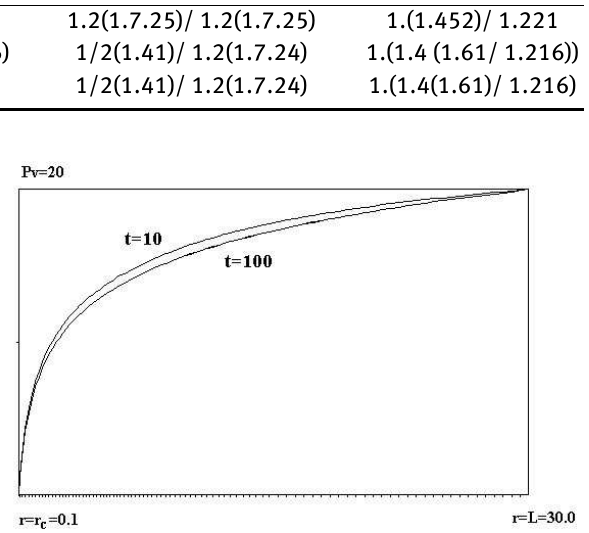
Figure 3: Pressure distribution